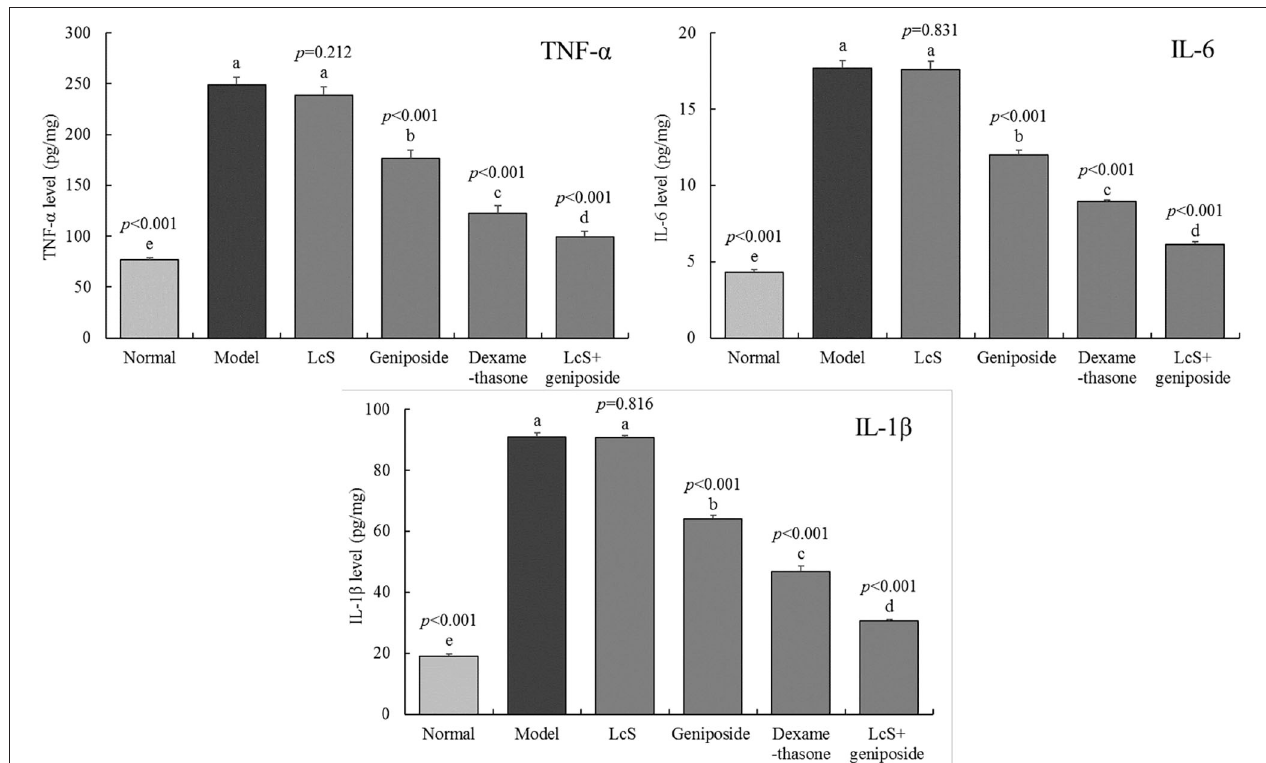
FIGURE 4 | Tumor necrosis factor alpha K(TNF- α ), interleukin-6 (IL-6), and interleukin-1 beta (IL-1 β ) cytokines levels of the hippocampus of mice with sepsis on the seventh day ( n = 8). The mean values are tabulated with mean ± standard deviation, and the p -value is the relative situation of the corresponding group to the model group. Normal: untreated mice; model: mice with induced sepsis; LcS: 5 × 10 7 CFU/kg-treated mice with sepsis; geniposide: 50 mg/kg geniposide-treated mice with sepsis; dexamethasone: 1 mg/kg dexamethasone-treated mice with sepsis; LcS + geniposide: 5 × 10 7 CFU/kg LcS and 50 mg/kg geniposide-treated mice with sepsis. a − e Mean values with different letters over the bar are significantly different ( P < 0.05) according to Tukey’s honestly significant difference